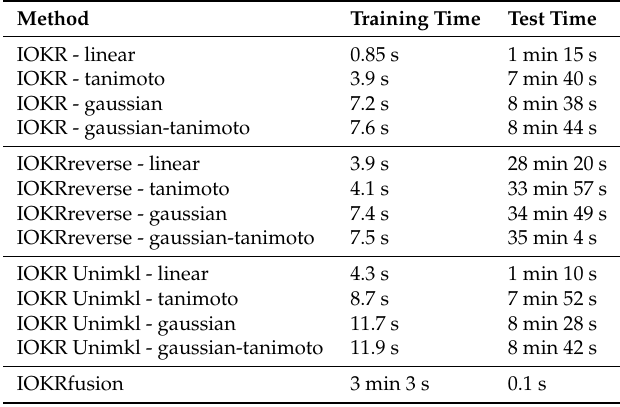
Table 3. Running times for the training and the test